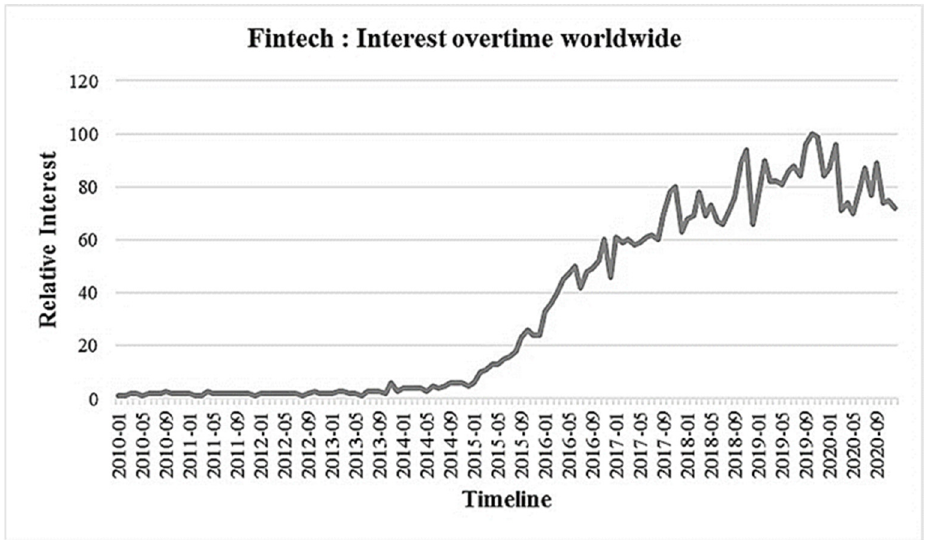
Figure 1. Worldwide interest over time for the term fintech. Source: Researchers’ own source.